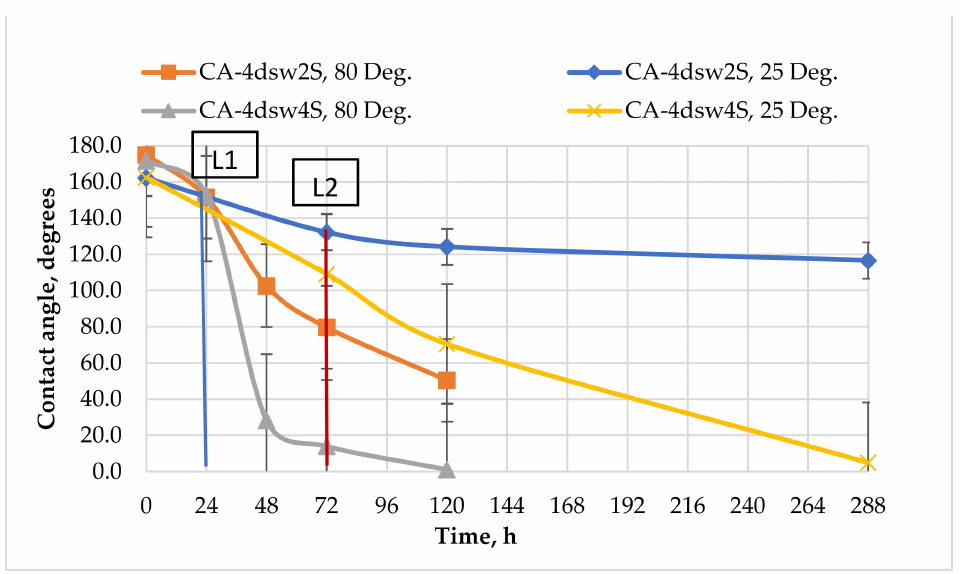
Figure 13. Effect of active ions (SO 42 − ) on the performance of EW and EW-NF, at room temperature and an elevated temperature of 80 ◦